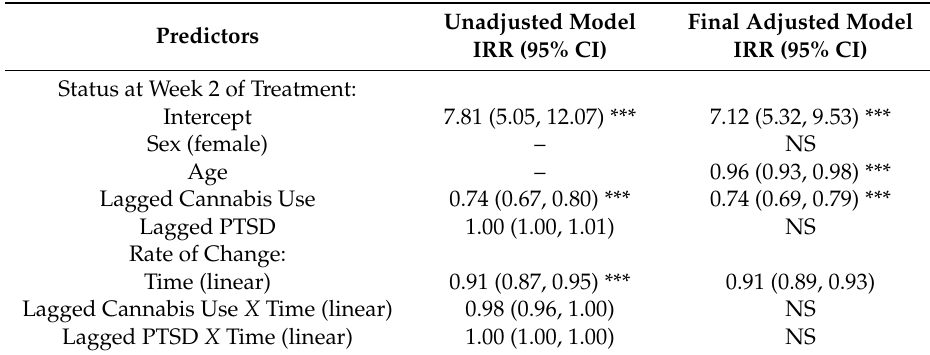
Table 3. Exponentiated regression coefficients for models examining the association of cross-lagged weekly cannabis use on primary substance use.